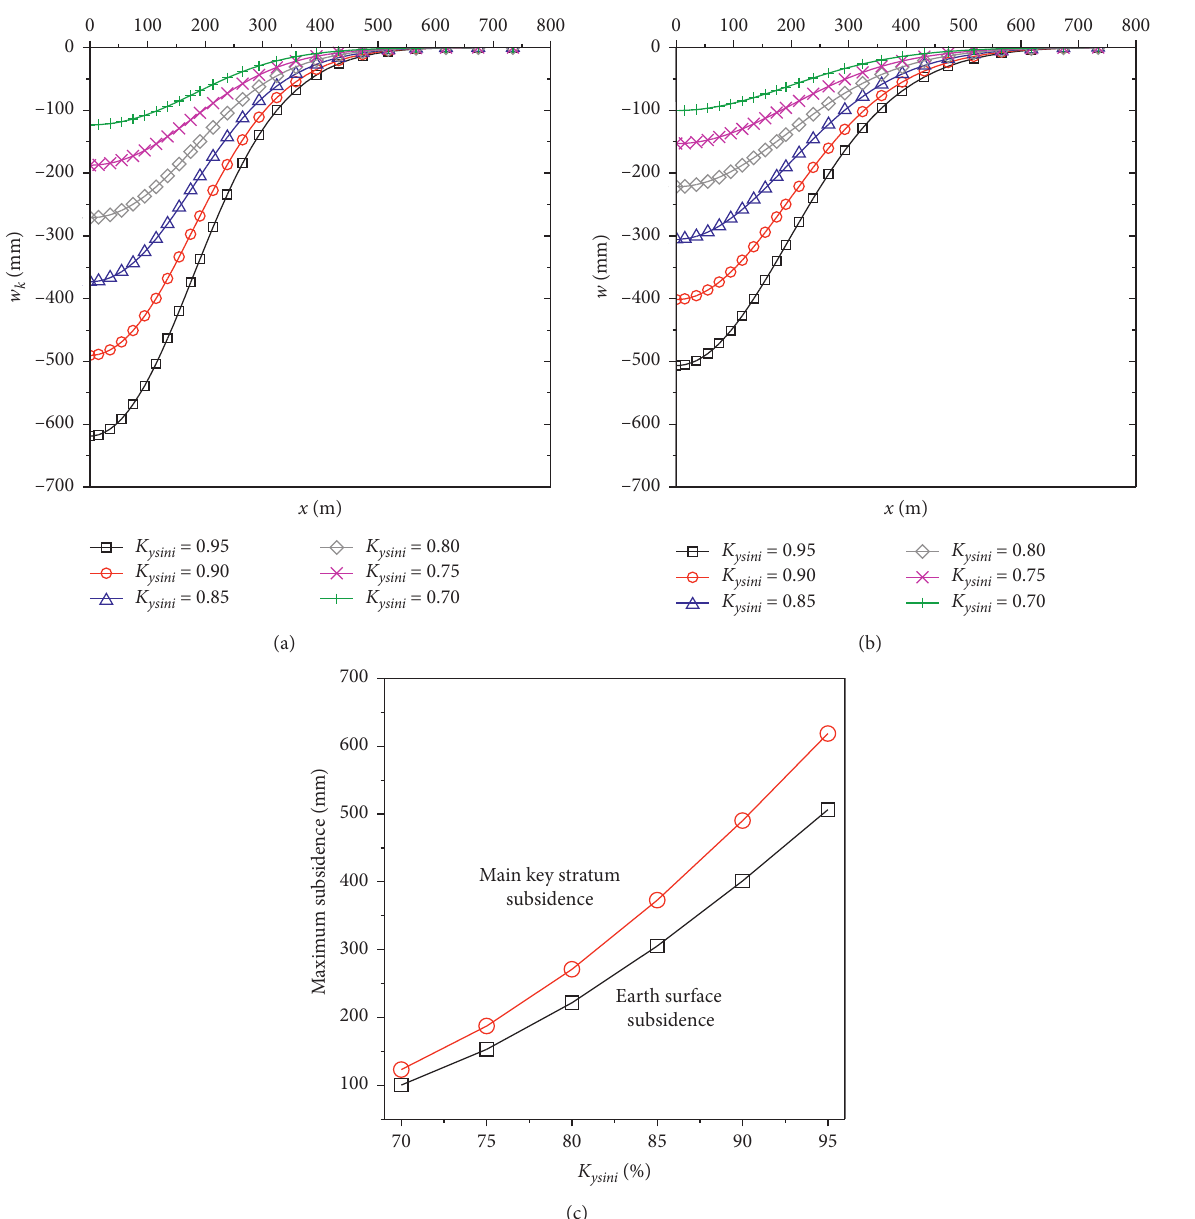
Figure 9: (a) Subsidence curve of main key strata, (b) surface subsidence curve, and (c) variation curve of maximum subsidence under different initial compaction